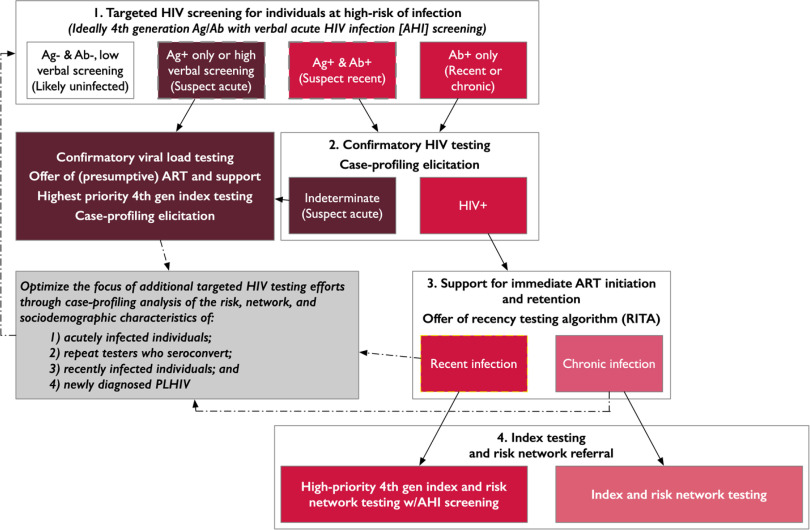
An Illustrative Workflow for Acute HIV Infection Screening, Additionally Applying Recency Testing Data to Help Improve FocusAbbreviations: Ab+, antibody positive; Ab−, antibody negative; AHI, acute HIV infection; Ag+, antigen positive; Ag−, antigen negative; ART, antiretroviral therapy; HIV+, HIV-positive; PLHIV, people living with HIV.